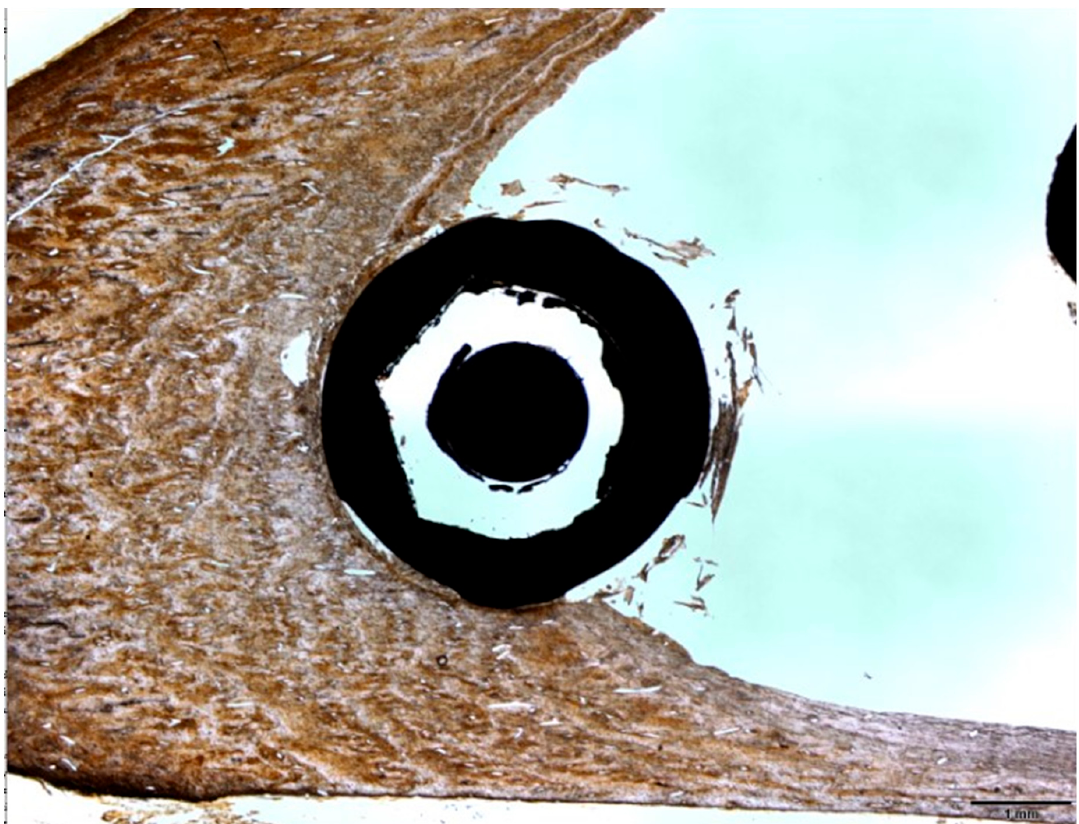
Figure 19. Histological image showing mineralized bone around the HA + AW implant. Von Kossa stain, 5× magnification. The difference in the quantity of the surrounding bone (between left and right sides) is due to the location of the implant in the most distal zone of the tibial metaphysis where bone is thinner. This is an anatomical limitation because this bone has different thickness over its whole length, being thicker on the proximal zone. This image is from a distal zone of implantation. To minimize this effect in all groups, implant locations in the proximal, middle, or distal zones was alternating for reducing this possible limitation/bias.